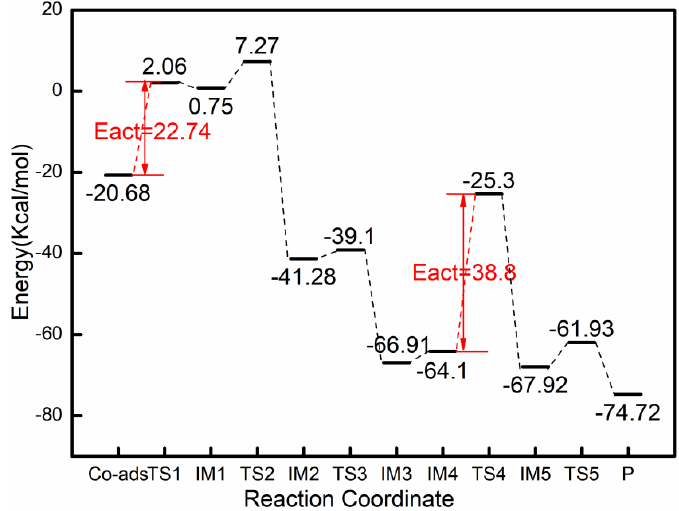
Figure 7. The energy diagrams of acetylene hydrogenation catalyzed by S-doped N site.